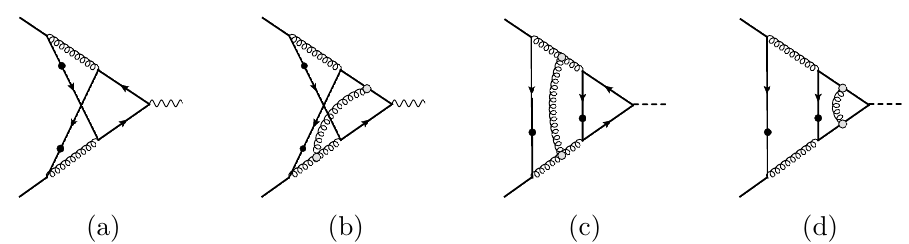
Figure 2 . (a) the leading two-loop Feynman diagram for the O ( m 3 to the quark Pauli form factor. The diagrams with an effective soft gluon exchange which incorpo- rate the non-Sudakov double-logarithmic corrections (b) to the O ( m 3 (d) to the O ( m 2 ) scalar form factor of a quark. The effective vertices (gray circles) are defined in q the